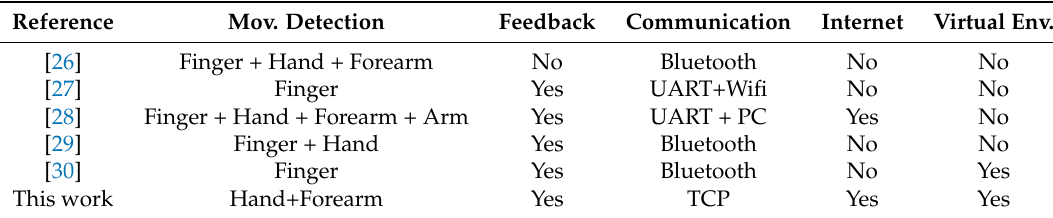
Table 2. Comparison of our proposed glove and other